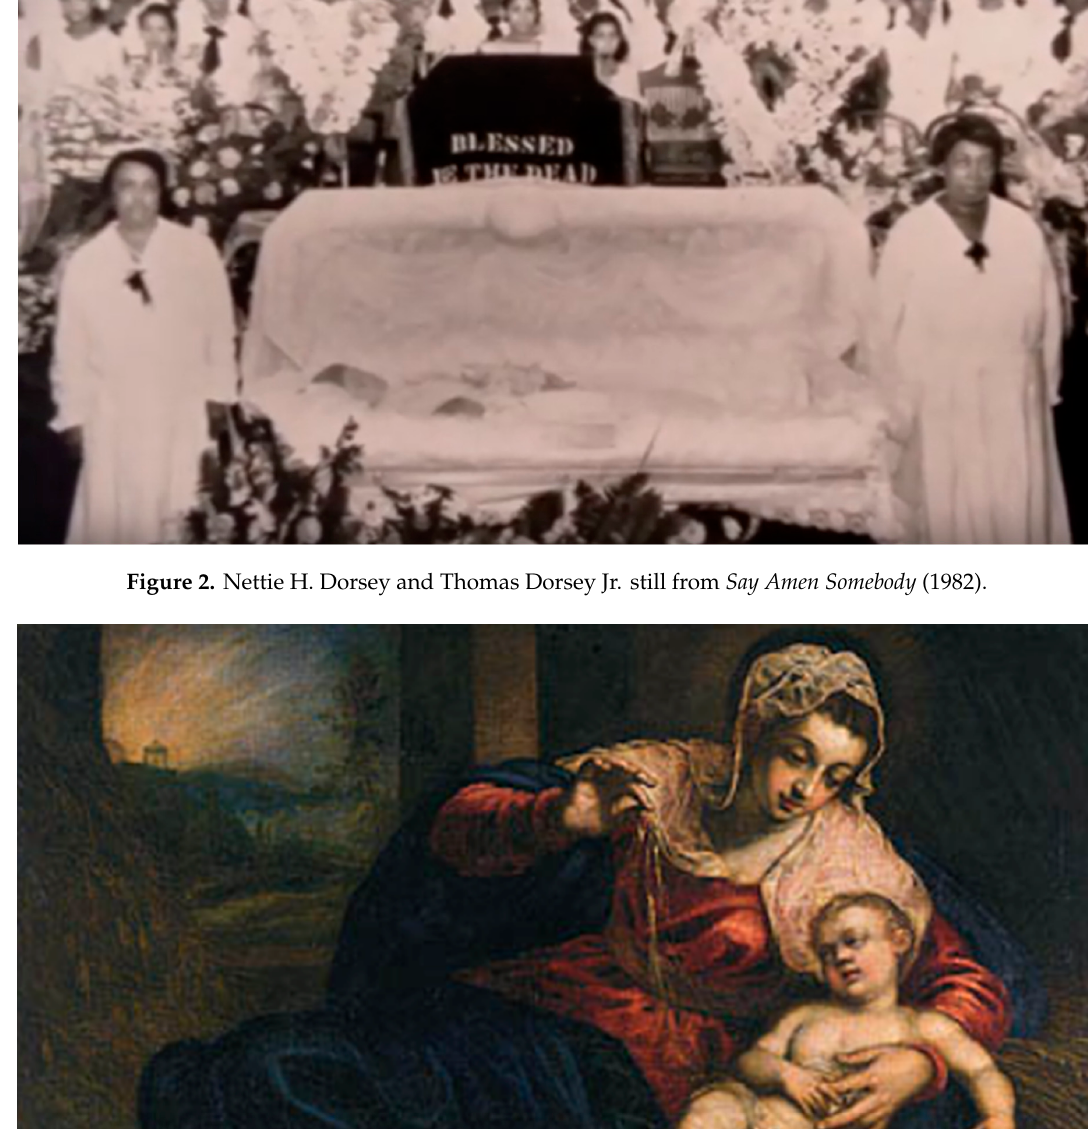
On the proximateness of black death to black life, see especially Christina Sharpe (Sharpe 2016).